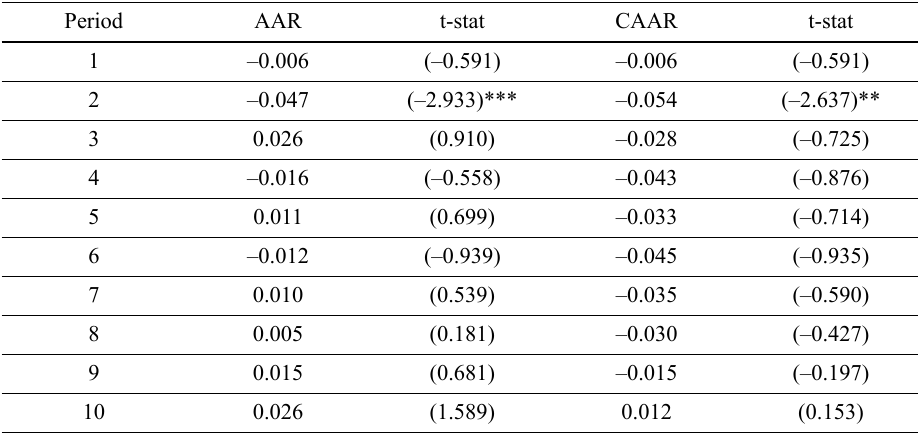
Table 3. Announcement window monthly abnormal returns for newly added